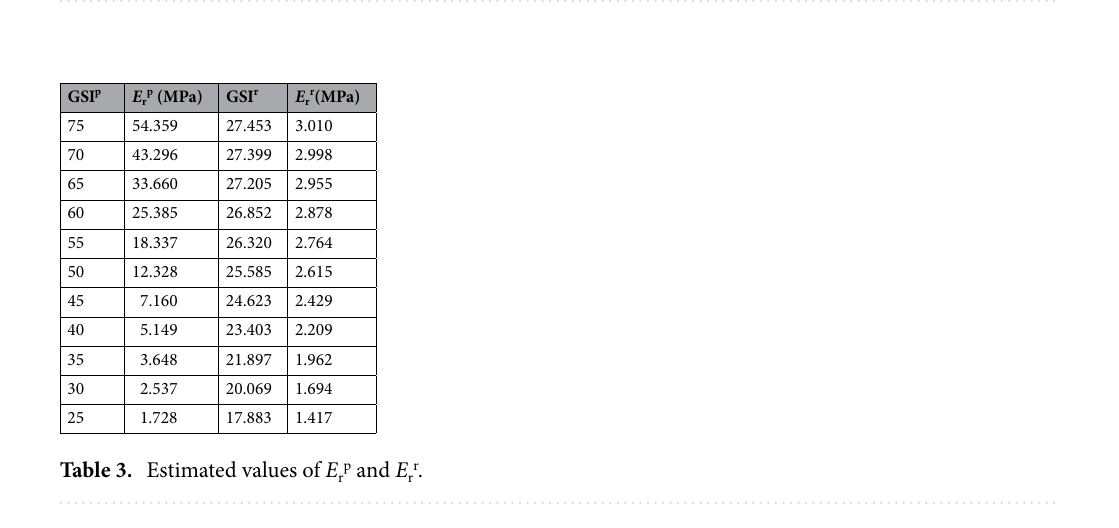
Table 2. Calculated values of E rp and E rr by Eqs. (11) to (14).